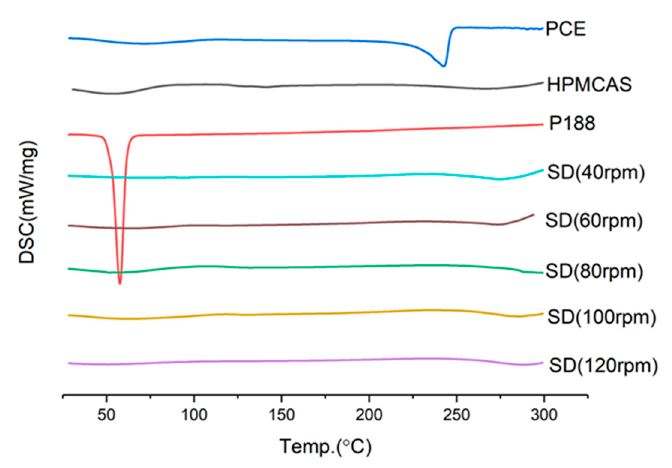
Figure 11. DSC diagram of solid dispersion prepared at different screw speeds.